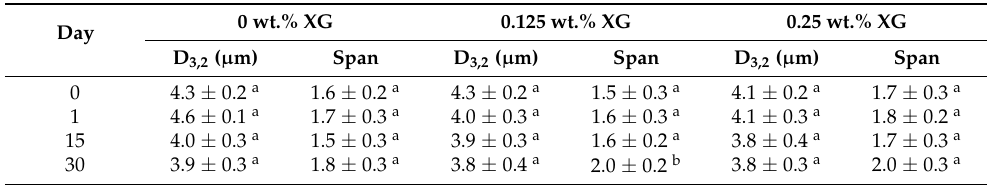
Table 8. Parameters from Droplet size distribution (D 3,2 and span) of W 1 /O/W 2 multiple emulsions obtained at two different xanthan gum (XG) concentrations: 0, 0.125 and 0.25 wt.%. 0 wt.% XG 0.125 wt.% XG 0.25 wt.% XG Day D 3,2 ( µ m) Span D 3,2 ( µ m) Span D 3,2 ( µ m) Span